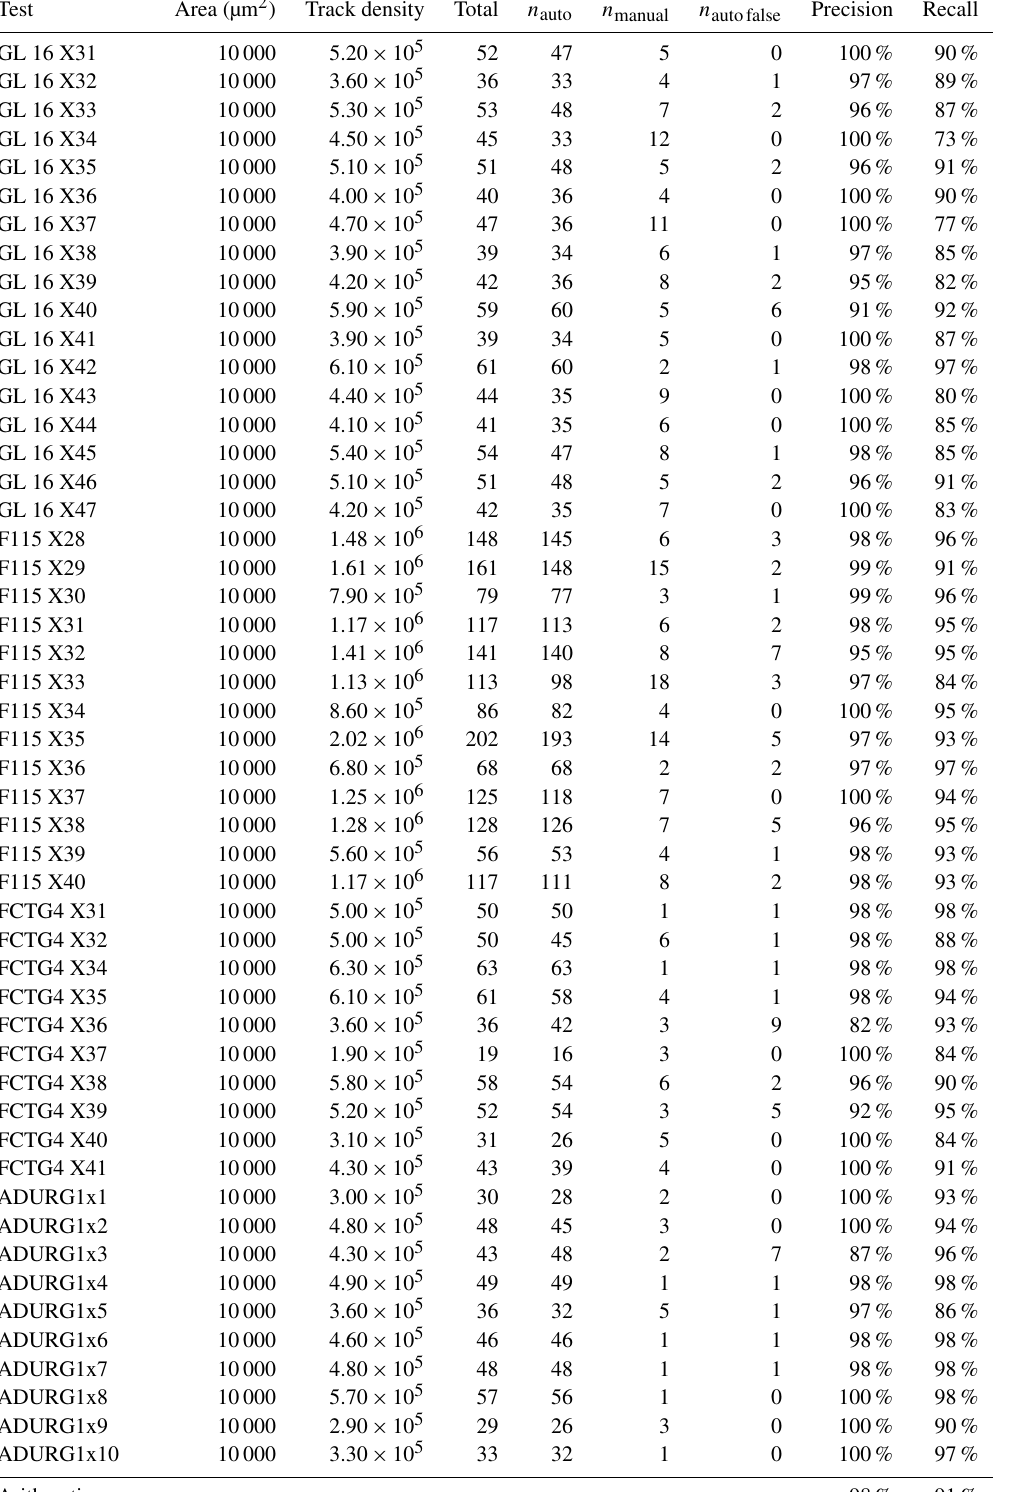
Table 2. Test results of the automatic fission track recognition in muscovite mica (confidence threshold = 0.3). Areal track density is ex- pressed in tracks per square centimetre (trackscm − 2 ). The number of correctly automatically detected tracks (true positives), manually detected tracks (false negatives), and erroneously detected tracks (false positives) are indicated by n auto , n manual , and n auto false